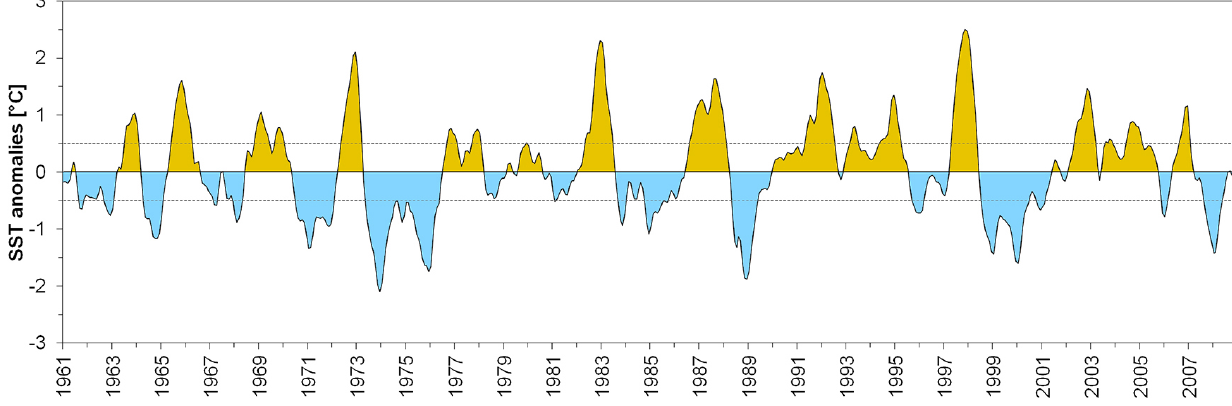
Figure 1. Time series of the Oceanic Niño Index for the period 1961–2008. Dotted lines indicate the ± 0 . 5 ◦ C